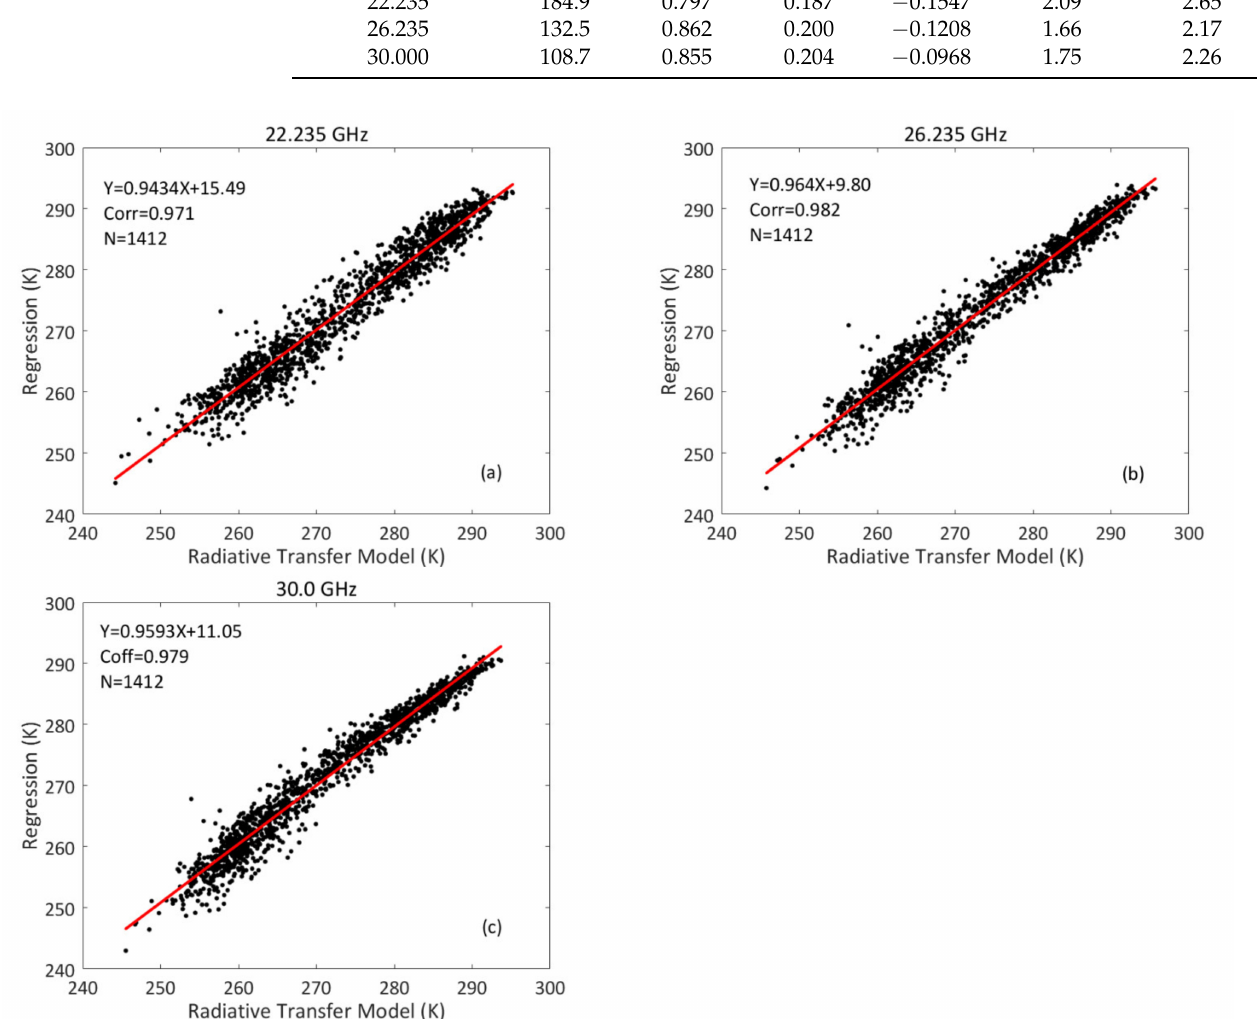
Figure 2. The mean radiative temperature at different frequencies. A comparison of the regression method and radiative transfer model using the sounding profiles when the sky was clear. The sample size (N), the correlation (Coff), and the fitting are shown. ( a ) 22.235 GHz, ( b ) 26.235 GHz, and ( c ) 30.0